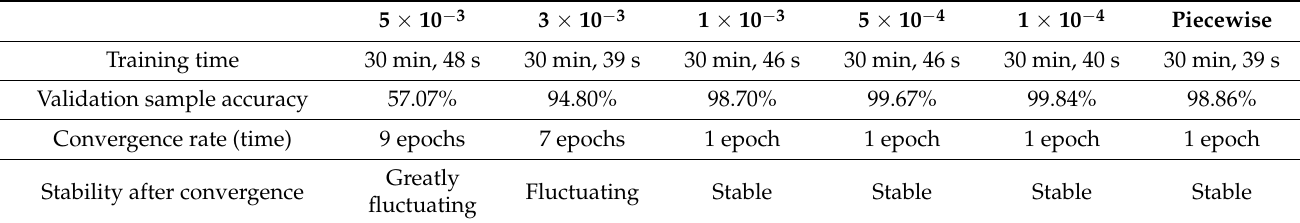
Table 3. Effect of different learning rates on SqueezeNet